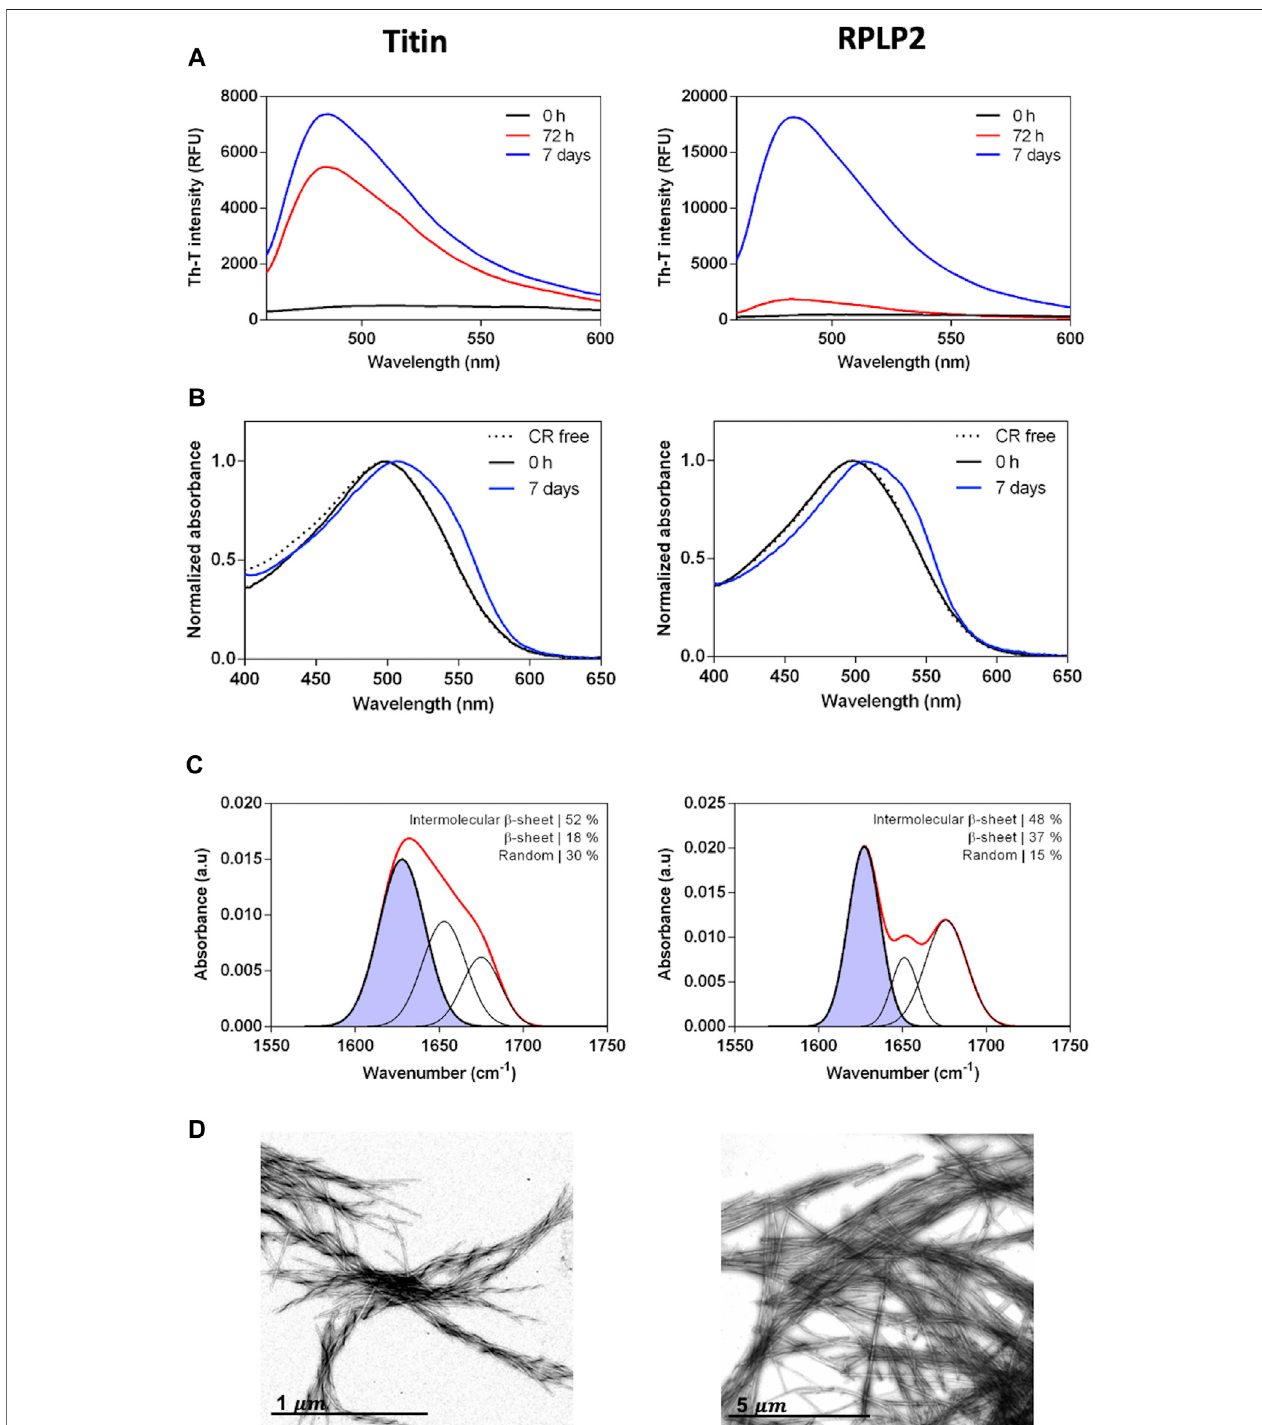
FIGURE 5 | Experimental characterization of the selected CARs-DB derived peptides, the 10429-EGVSISVYR-10437 segment of titin protein (left panels) and 69- GAVAVSAA-76 of RPLP2 (right panels). (A) Thio fl avin-T fl uorescence emission spectra at 0 h, 72 h and 7 days of 200 µM of the peptides incubated at 37 ° C with continuousagitationat100 rpm. (B) CRabsorbancespectraoftheincubatedsamplesat0 hand7 days.CRabsorbancespectrumintheabsenceofpeptideisincluded as a control (dashed line). (C) Determination of the secondary structure of incubated peptides by ATR FT-IR. The red line corresponds to the absorbance spectra andthepurpleareaindicatestheinter-molecular β -sheetcontributiontothetotalareauponGaussiandeconvolution. (D) RepresentativeTEMmicrographsofthepeptide fi brils.